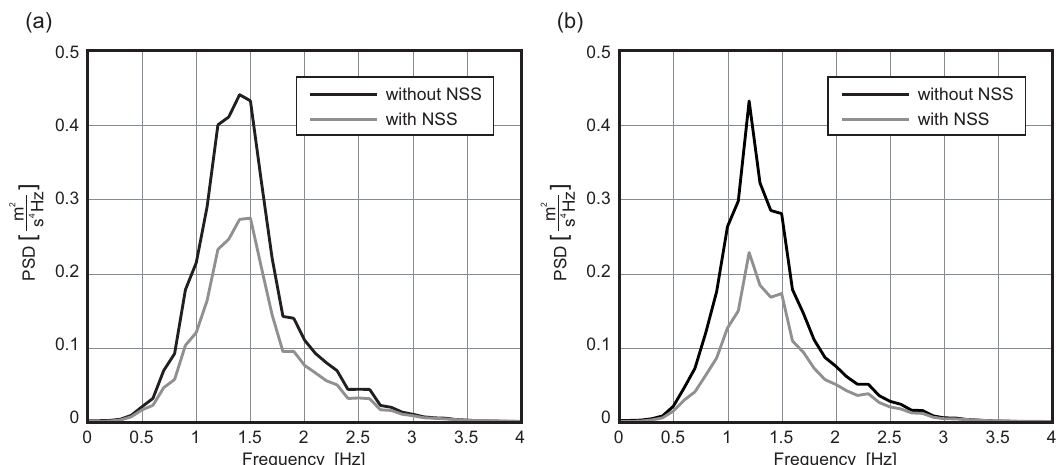
Figure 8. PSD of the weighted acceleration obtained with and without NSS for road profile Type D and two different masses: ( a ) 60 kg and ( b ) 90 kg.